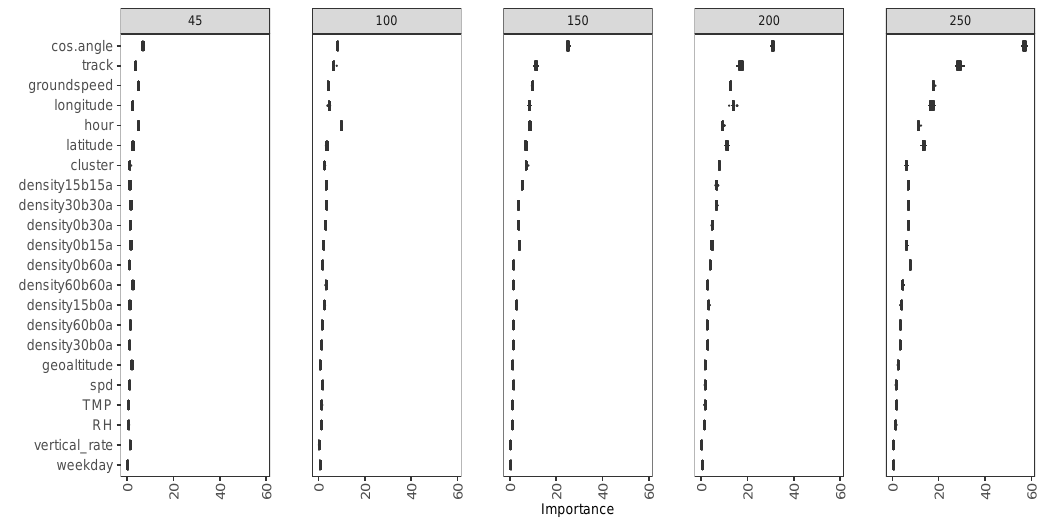
Figure 9. Unconditional Feature importance evaluated by random forest